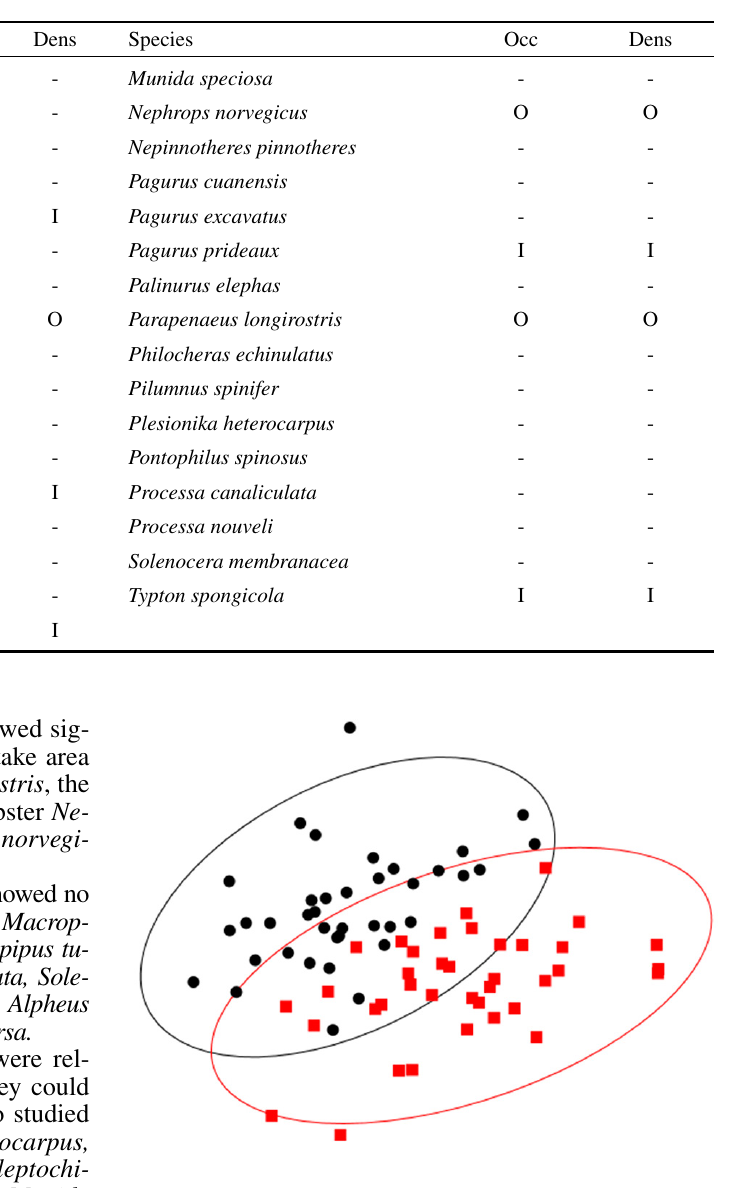
Fig. 2. – Non-metric multidimensional analysis (MDS) run on the matrix of decapod crustacean species densities by sample. Samples taken were categorized according to whether they belonged to the no-take area (black dots,) or to the open area (red squares). Each dot represents one trawl sampling operation. The ellipses shown encom- pass the area where 95% of the samples within each category would be expected to